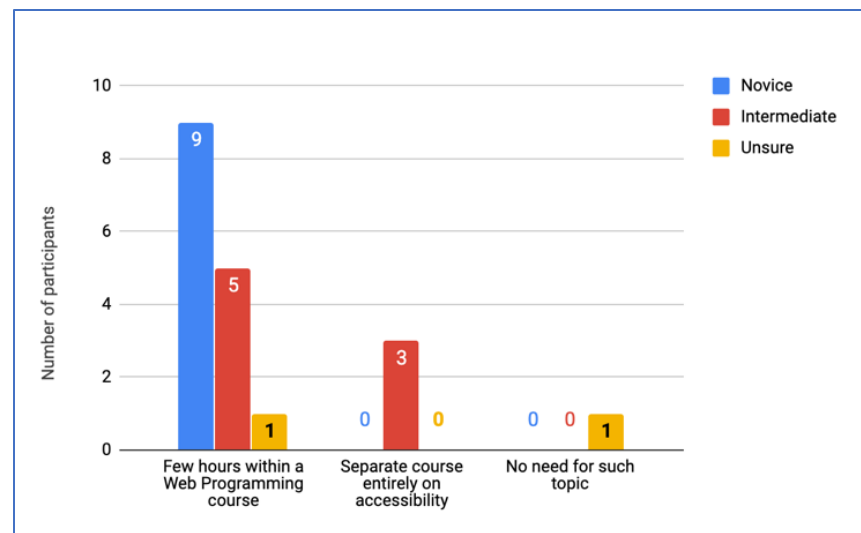
Figure 4. Preference of teaching the topic of accessibility in courses.